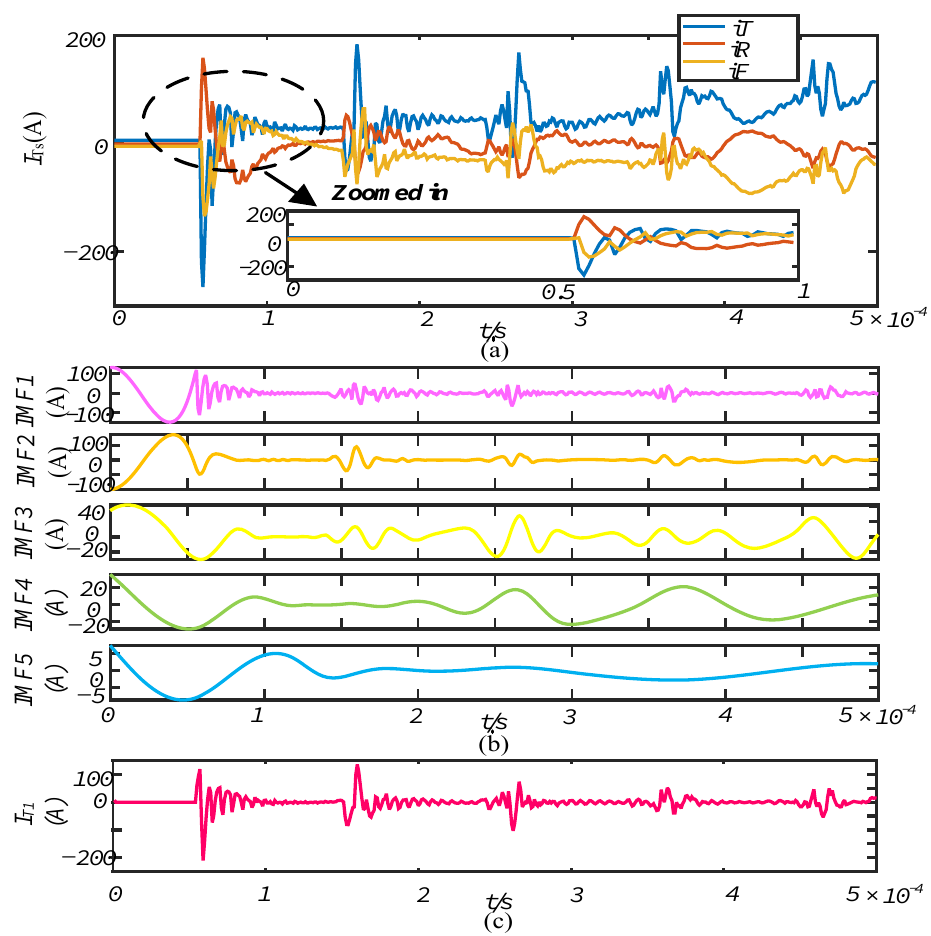
Figure 9. Analysis diagram of counterattack flashover waveform and improved HHT signal.